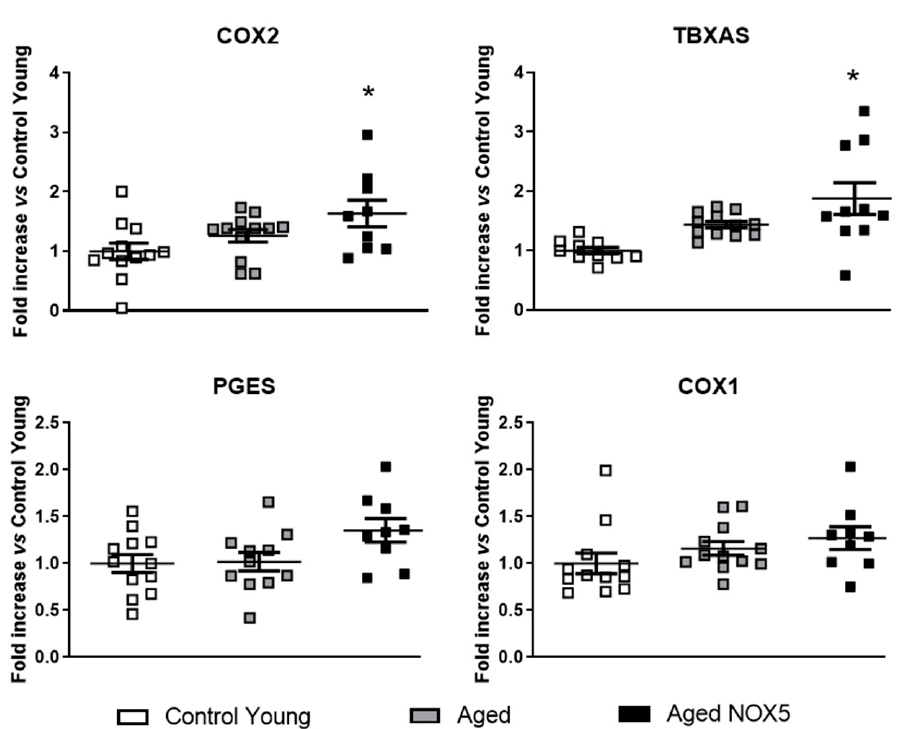
Figure 4. Alterations in mRNA expression of the PG pathway components due to aging and NOX5. The mice cerebral mRNA levels of COX2, TXA2S, PGES and COX1. * p < 0.05 vs . Control Young . n = 11–14. The results are expressed as the mean ± SEM. The Kruskal–Wallis test was used for the COX2 analysis, and one-way ANOVA was used for the other genes analyzed. Control Young : Young mice, Aged : CRE +/ − aging mice and Aged NOX5 : NOX5 +/ − CRE +/ − aging mice.